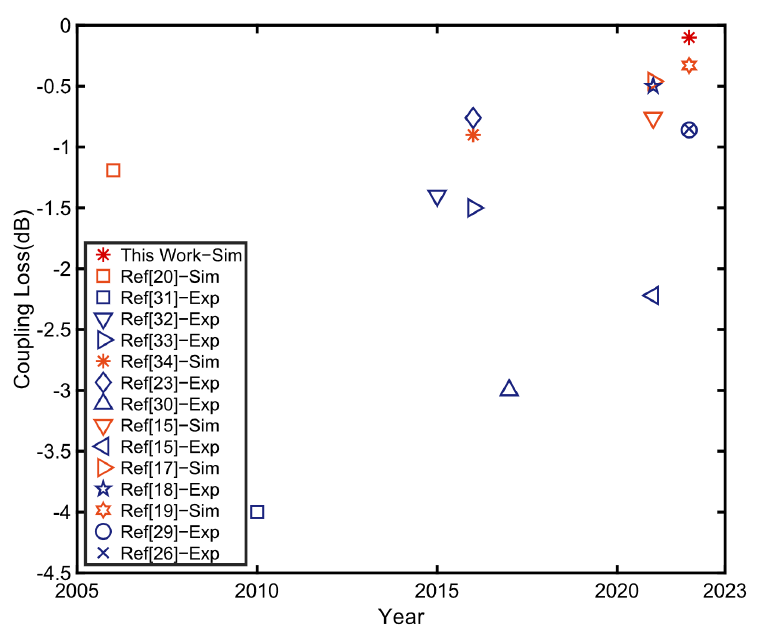
Figure 6. Performance comparison of waveguide edge couplers coupled with SMF-28.